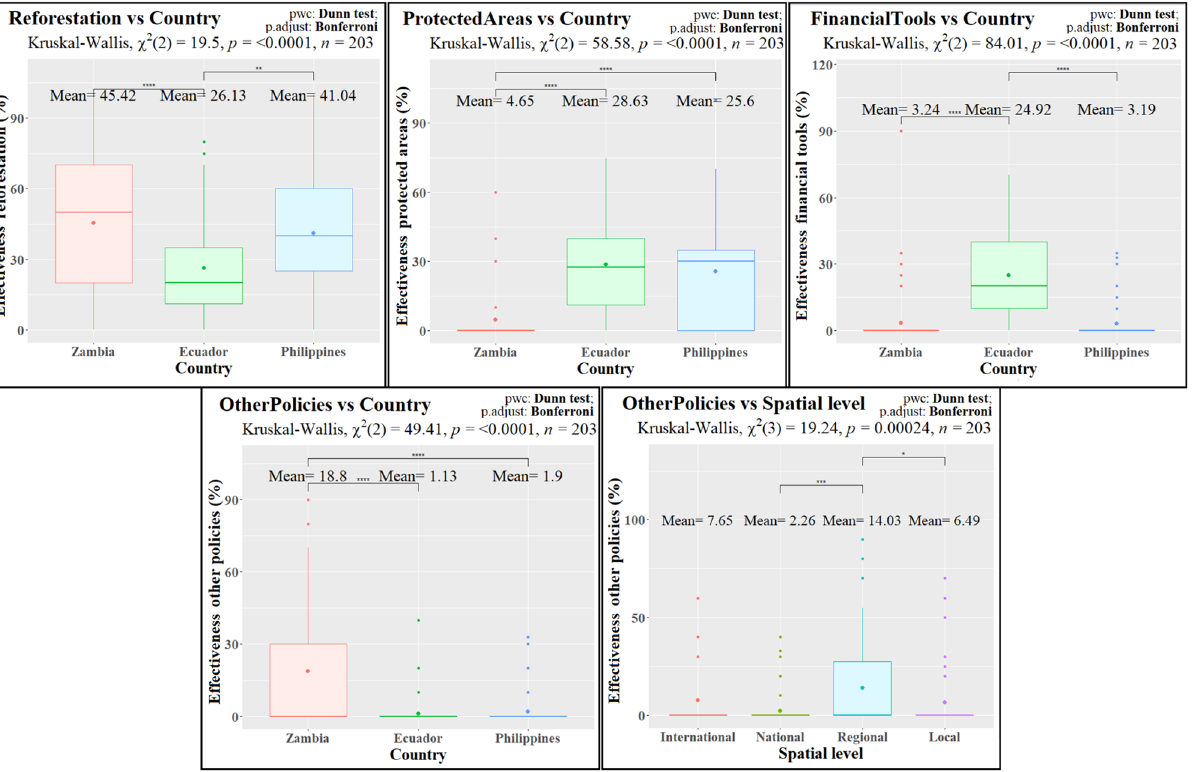
Figure 4. Results of the Kruskal–Wallis and Dunn tests across countries and spatial levels for the variables related to the expected effectiveness of policy instrument categories. Only tests with statistically significant results are shown. Boxplots including mean values (Mean), chi square statistic ( χ 2 ), p-values (p) and number of observations (n) of the Kruskal–Wallis tests and p-adjustment (p. adjust) and p-scores (sign, ****: < 0.0001, ***: < 0.001, **: < 0.01, *: < 0.05, ns not significant [> 0.05]) for the Dunn pairwise comparisons